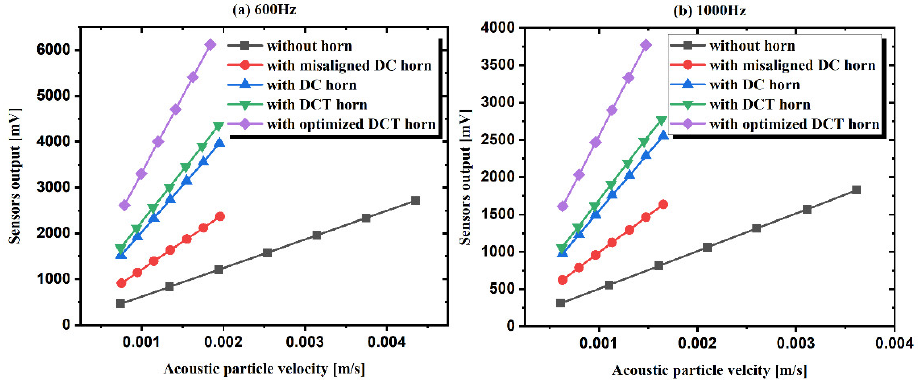
Figure 12. Responses of TAPVS with and without acoustic horns to particle velocity at: ( a ) 600 Hz and ( b ) 1000